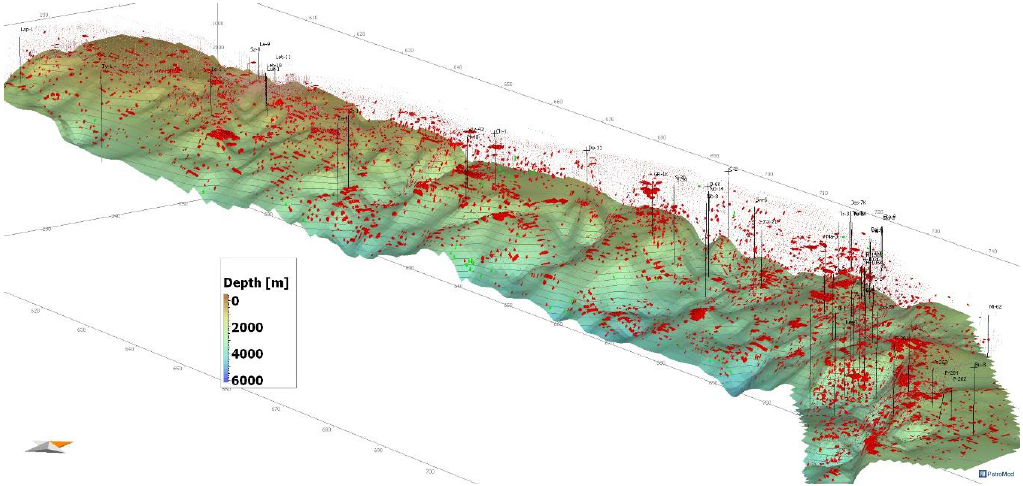
Figure 11. Illustrative distribution of conventional gas accumulations in sandstone horizons of the study area as predicted by the model (red spots represent modeled gas accumulations with resources corresponding to reserves of proved gas fields and approximately representing their distribution across the study area).